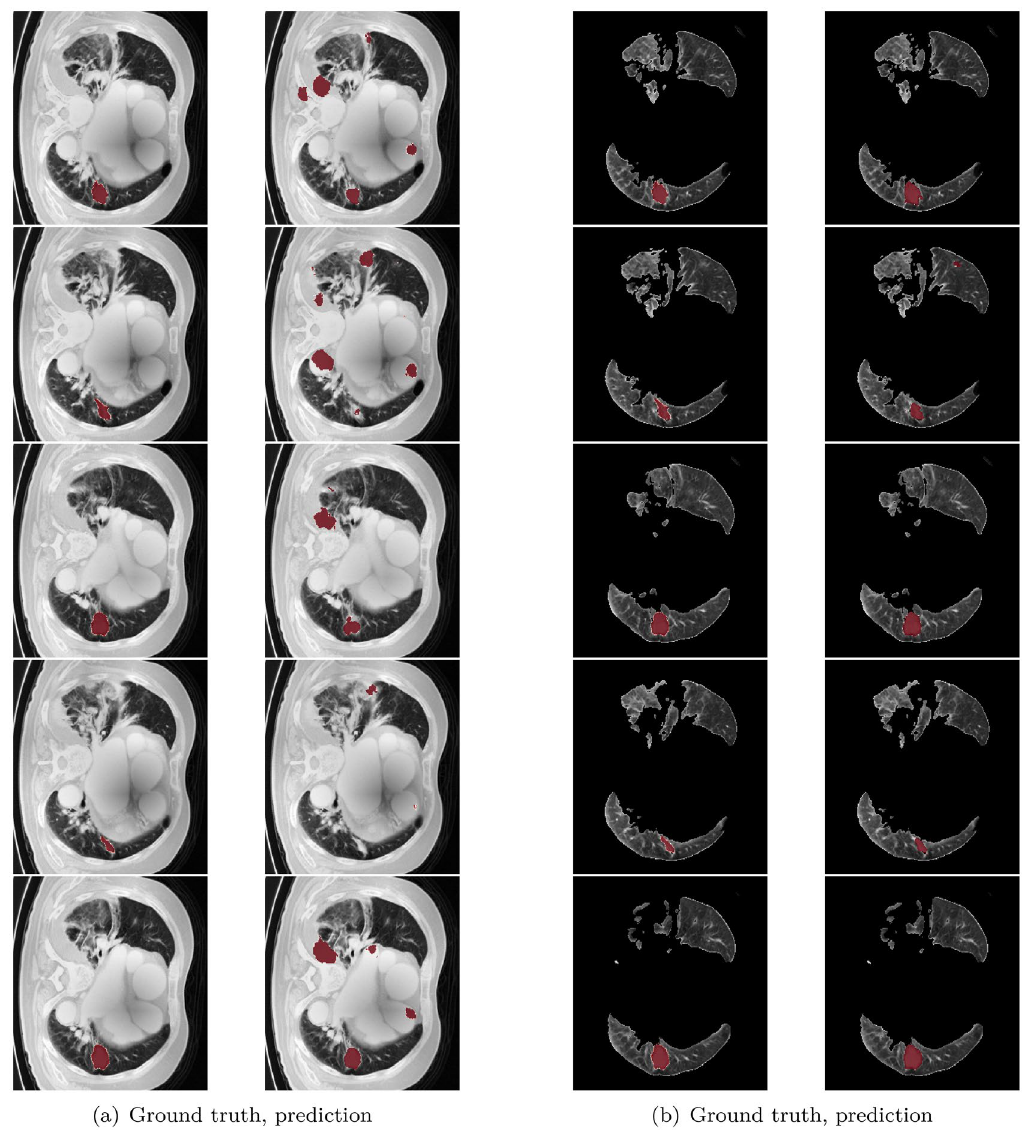
Figure 8. Left: With CLAHE and Wiener, Right: With CLAHE, Wiener and ROI Complementary labeling. As mentioned, complementary labeling is considered to train the U-net. With two dimensions of labeling use the same loss function. The model will tend to decrease the loss in two labeling dimensions. In other words, the weight of per pixel decreases. In the output, the results of two dimensional predicted output are obtained by performing interaction with them. Table 2 shows the comparison among dif- ferent methods in our testing data, without pre-processing and with pre-processing (with CLAHE, wiener filter, and ROI segmentation). From the table, it can be found that the Sensitivity is improved from 0.90 to 0.96 and the dice coefficient is improved from 0.573 to 0.790 due to the pre-processing. Also, the results are considered with different labeling ways in mono or in hybrid. Mono means only one label input in positive or negative (complementary labeling) is used and hybrid means two label inputs in positive or negative output are used. It shows that whether using positive or negative ground truth as model input, the result cannot be better than using mono input significantly. It seems that using complementary labeling is not effective under the big data quantity condition. Different data quantities, 472 cases and 50 cases are considered in this study. As shown in Table 3, it seems that using complementary labeling with pre-processing gets a better result than using mono input. But without pre-processing, complementary labeling is not efficient. It is worthwhile to use the complementary labeling method in small data quantity. That is why in this study complementary labeling is considered. The sensitivity of small data quantity, the hybrid negative is higher than using mono input positive with the pre-processing conditions. The hybrid negative is 0.9716 and the mono input positive is 0.9560. Thus, if data quantity is not big enough, trying to use complementary labeling is a good method to get better result.